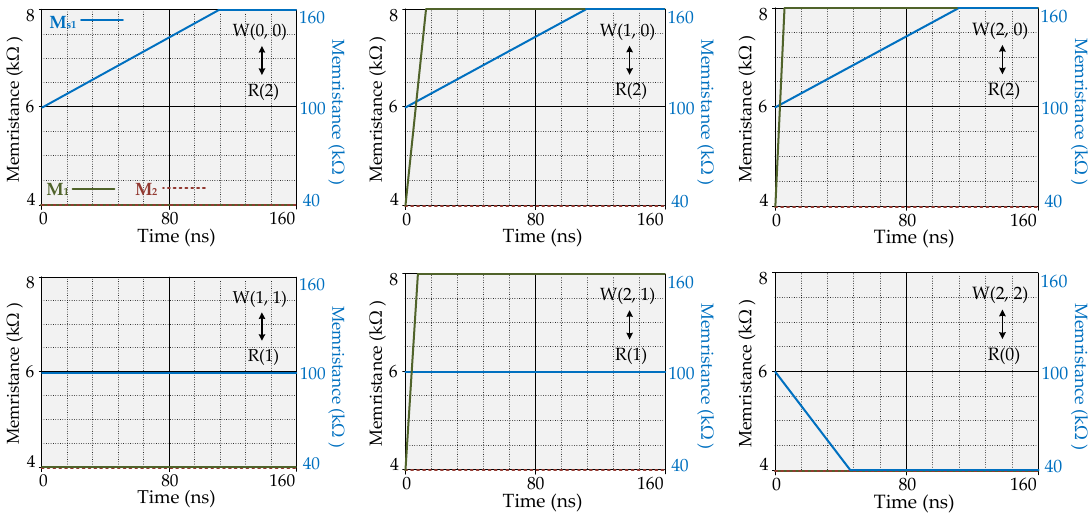
Figure 7. The relationship between the memristance and time during a ternary NAND operation.